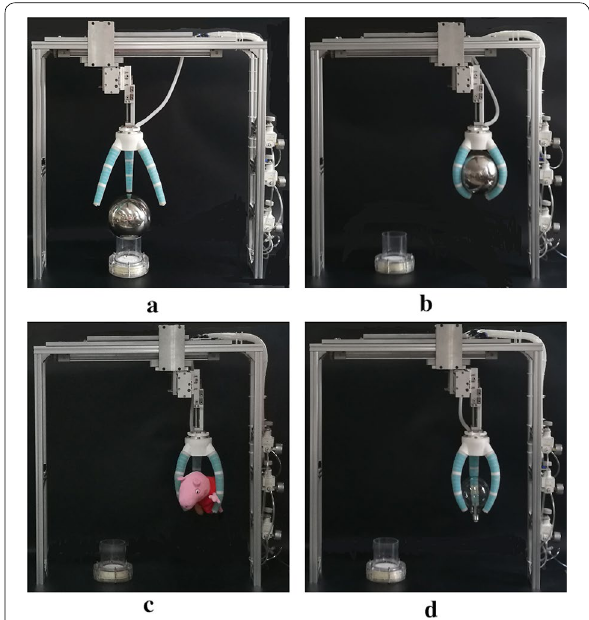
Figure 15 a Ready for gripping; b Gripping an aluminous sphere; c Gripping a cloth doll; d Gripping a glass